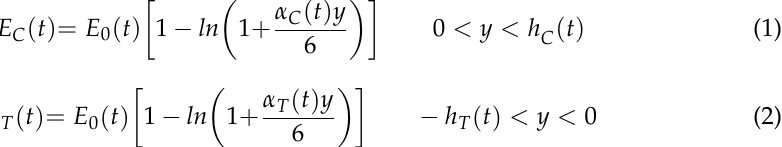
The parameters α neutral axis. In this paper, α